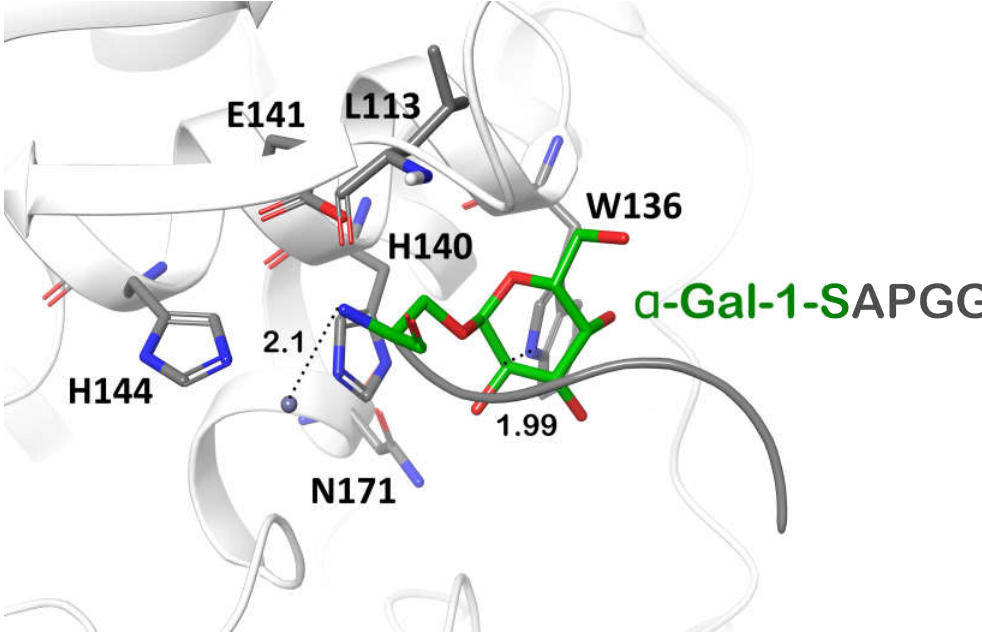
Figure 8. The structure of the peptidase domain active site of the Svx protein of Pectobacterium atrosepticum with a α -Gal-1-SAPGG ligand. The ligand was built based on the structure of the ligand previously used for the study of ZmpB-substrate interaction (pdb code 5KDS) [39].